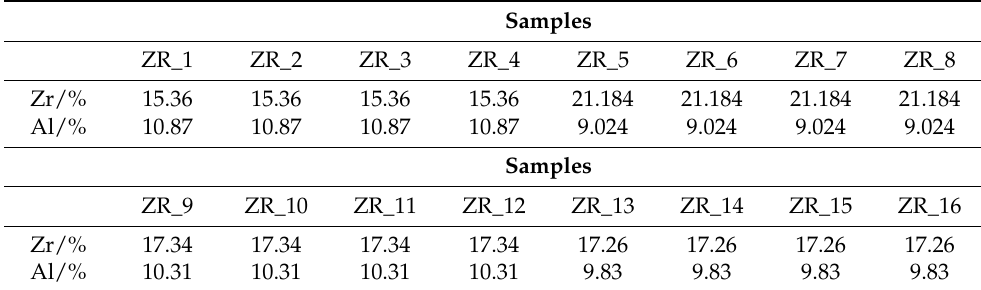
Table 2. Values of atomic fractions (%) of Zr and Al in the investigated sandblasted samples (see Table 1) obtained by EDX. ZR has 22.94% Zr and 0%